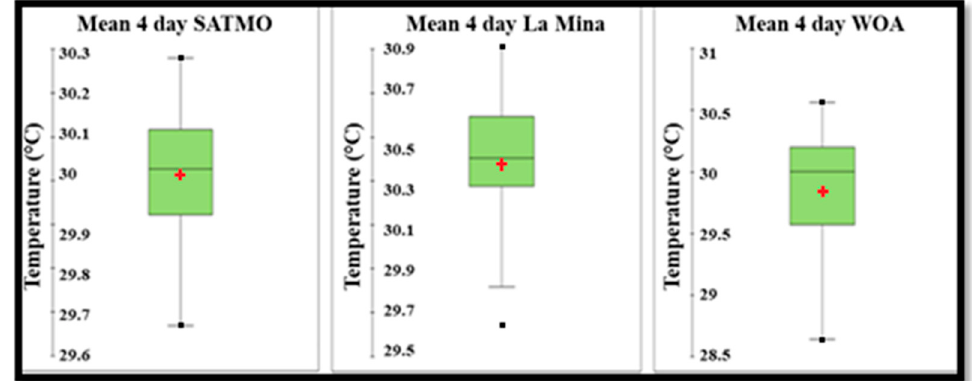
Figure 7. Mean and standard deviation for SATMO, WOA and in situ measurements at La Mina. The